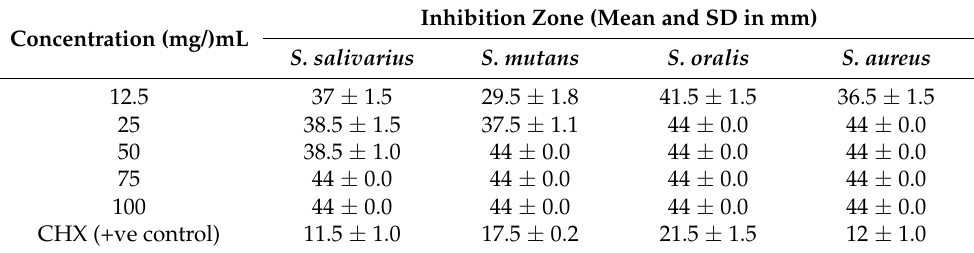
Table 1. Microbial inhibition zone in millimeters provided by TQ at different concentrations compared to a positive control (CHX).